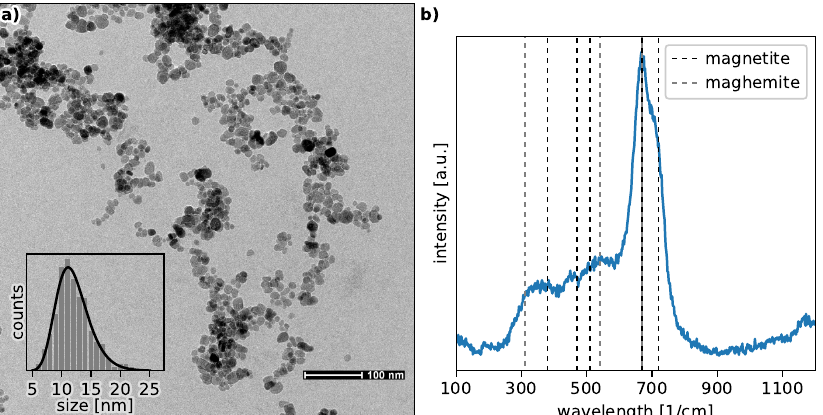
Figure 2. Panel ( a ) shows the TEM image for the bare MNP from the solution at the pH = 11.5. The nanoparticle-size distribution histogram and the log-normal function with the fitted parameters µ = 11.7 nm and σ = 0.24 are presented as the inset. Panel ( b ) presents the Raman spectrum for the bare MNP with the positions of distinctive Raman peaks for magnetite and maghemite.